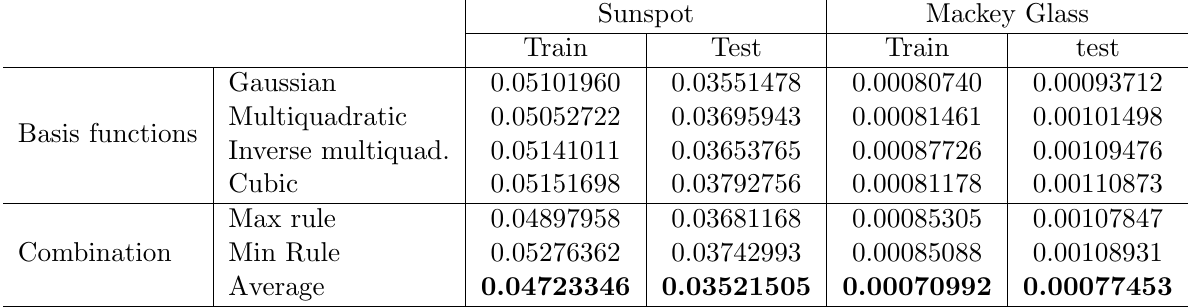
Table 4. Combining the NARX-RBFNNs